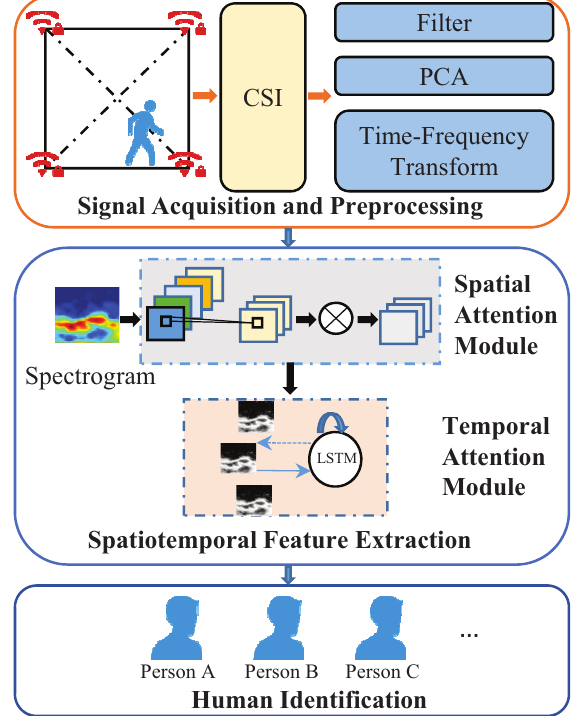
Figure 1. Architecture of Wireless